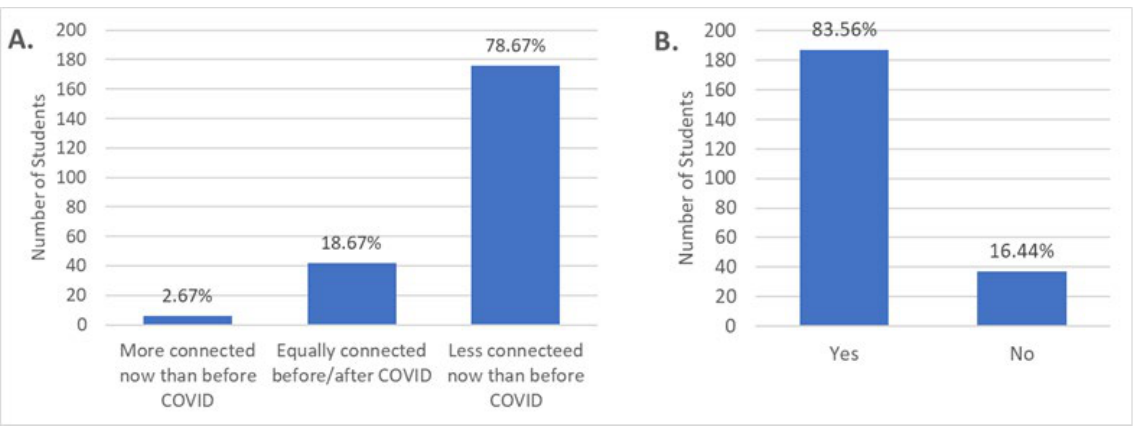
Figure 1: (A) Student reflection on how connected they feel to campus, and (B) level of appropriateness of